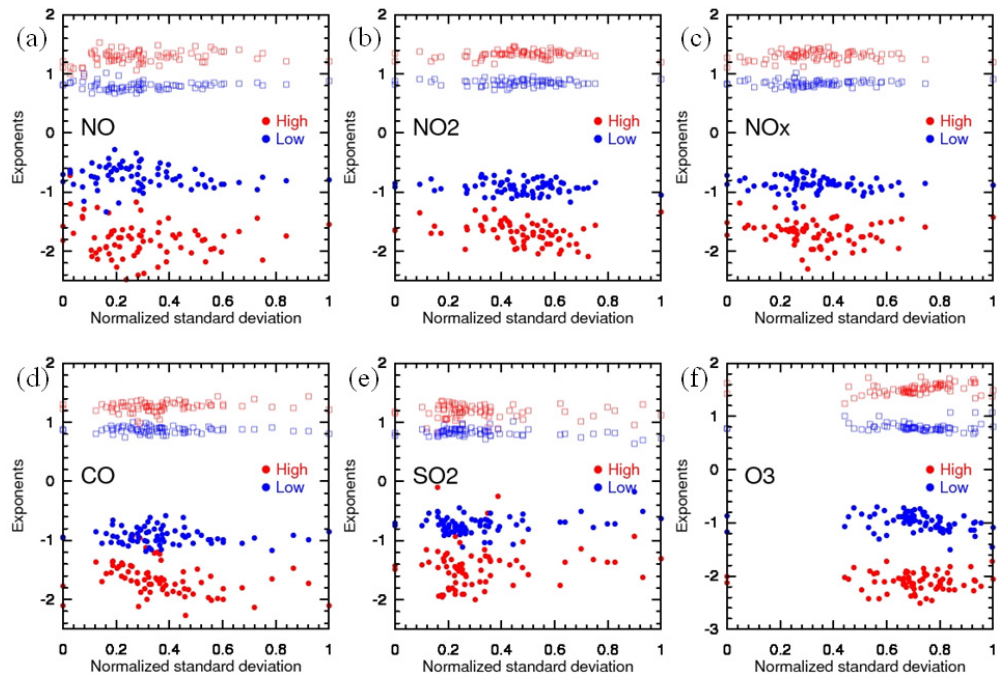
Fig. 7. The relationships between exponents and normalized standard deviations for NO (panel a ), NO 2 (panel b ), NO x (panel c ), CO (panel d ), SO 2 (panel e ), and O 3 (panel f ). Exponents from high- and low-frequency bands (HFB (red dots) and LFB (blue dots)) of CWT spectra and those from small and large time-lag bands (STLB (red squares) and LTLB (blue squares)) of DFA are presented separately for each